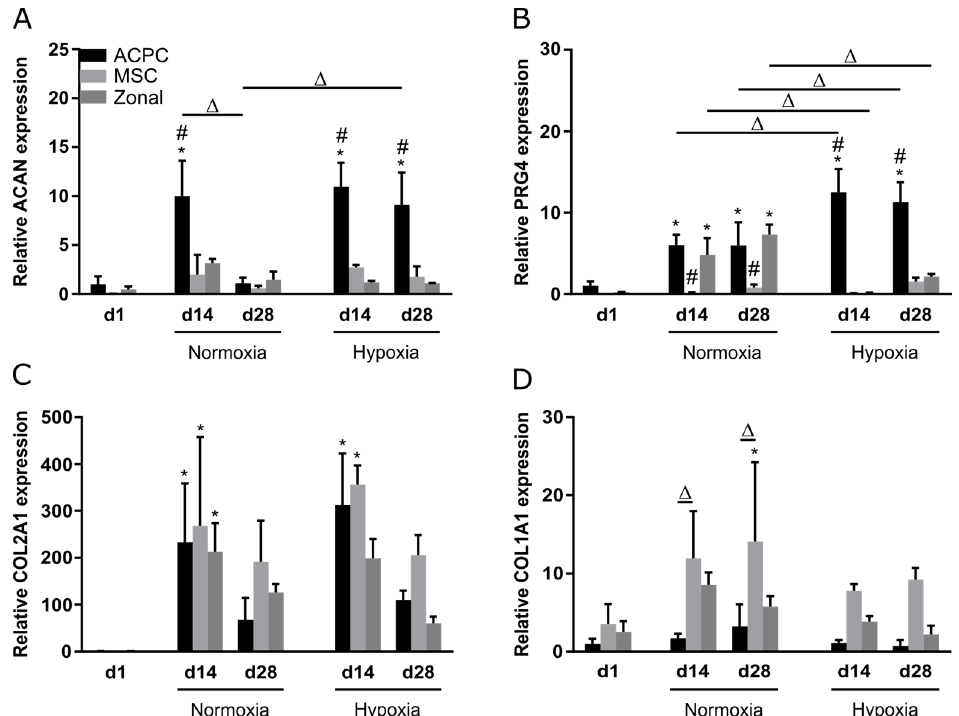
Figure 5. Relative gene expression in ACPC, MSC, and zonal constructs. Gene expression as determined by RT-qPCR in agarose hydrogel constructs, seeded with 20.0 × 10 6 cells mL − 1 , after 1, 14, and 28 days of chondrogenic differentiation under hypoxic and normoxic conditions. ACPCs and MSCs were either cultured alone or in zonally layered co-culture constructs. Relative expression of ( A ) ACAN (encoding aggrecan), ( B ) PRG4 (lubricin), ( C ) COL2A1 (type II collagen), and ( D ) COL1A1 (type I collagen). Data are presented as means ± standard deviations ( n = 3 biological replicates). Note: (*) indicates statistically significant differences between a d14 or d28 value and the corresponding d1 value of the same group ( p < 0.05); (#) indicates statistically significant differences of this group compared to the other two groups that share the same time point and oxygen condition ( p < 0.05); ( Δ ) indicates statistically significant differences between groups, or within a group between time points ( p < 0.05).